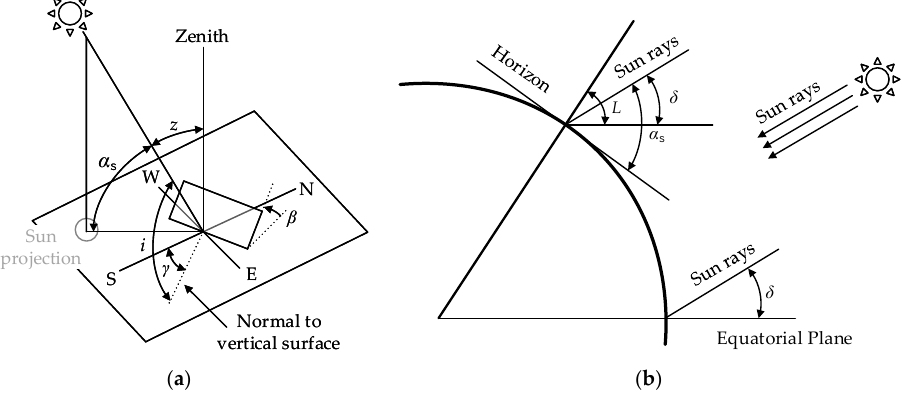
Figure 5. Description of angles—( a ) zenith angle z , angle of incident i , inclination angle β, and azimuth angle γ ; ( b ) declination angle δ and latitude L . angle γ ; ( b ) declination angle δ and latitude L